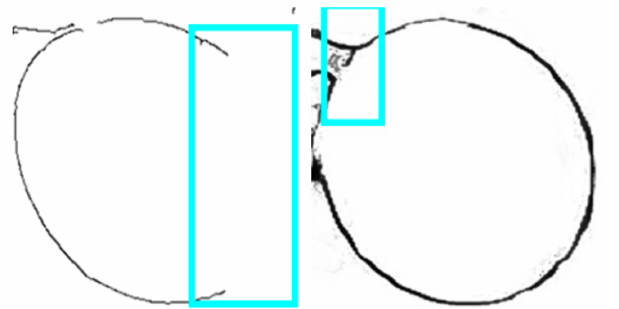
Figure 3. Grapes with missing contours.